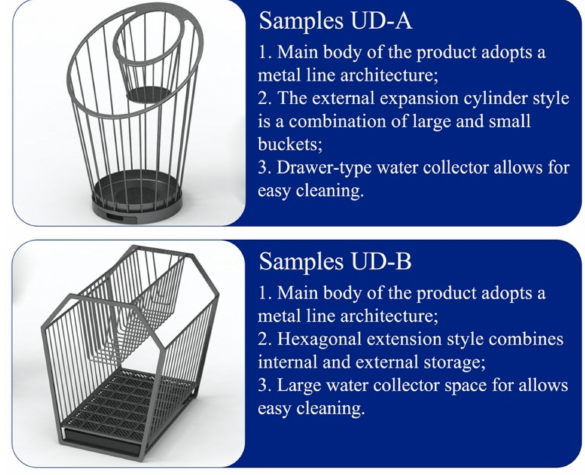
Figure 4. UD umbrella-stand